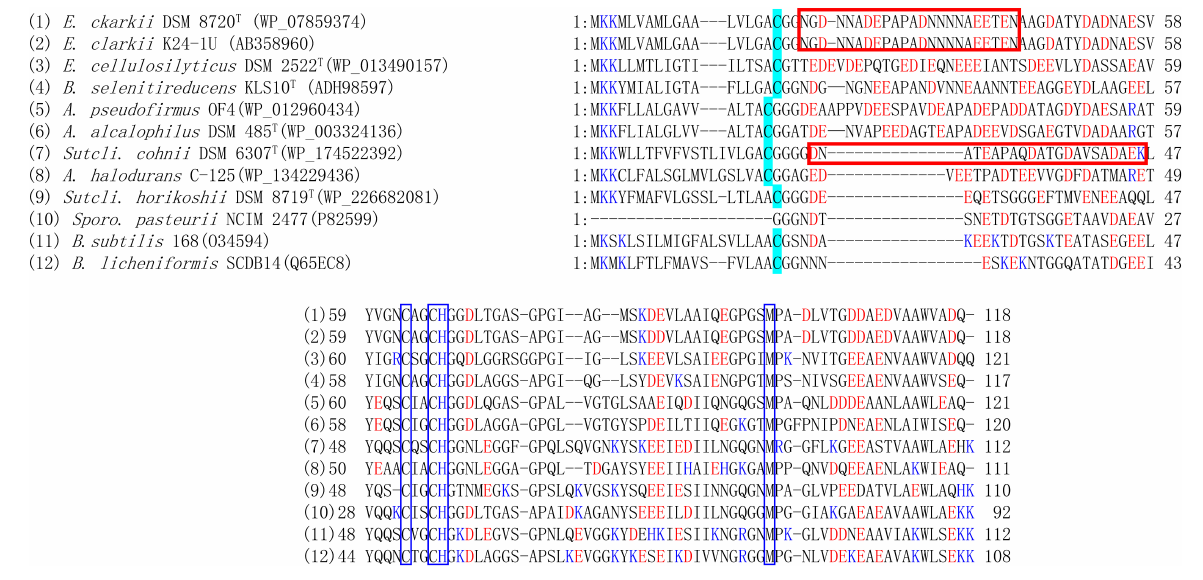
FIGURE 2 | Amino acid sequence alignment of membrane bound cytochrome c -550 from Evansella clarkii and other alkaliphilic and neutralophilic Bacillaceae . Asn (N)-rich segment, Asn (N) 21 -Asn (N) 43 [Asn (N) 4 -Asn (N) 26 in the processed protein base] in the E. clarkii cytochromes c is indicated by red box. The acid residue-abundant segment of Glu 25 -Lys 46 (Glu 6 -Lys 27 in the processed protein base) in S. cohnii DSM 6307 T is indicated by red box. N-terminal amino acid residue in processed cytochrome c , [Cys (C)] is indicated by blue marker. The blue boxed sequences are heme sequences representing heme-binding site and axical ligands (H and M). Acidic and basic residues are indicated by blue and red letters. Although A . pseudofirmus OF4 is a facultative alkaliphile, the species A . pseudofirmus and the presented cytochrome c sequence are classified in obligate alkaliphile. Although Sporosarcina pasteurii is an obligate alkaliphile, its cytochrome c sequence is similar to those in the facultative alkaliphilic